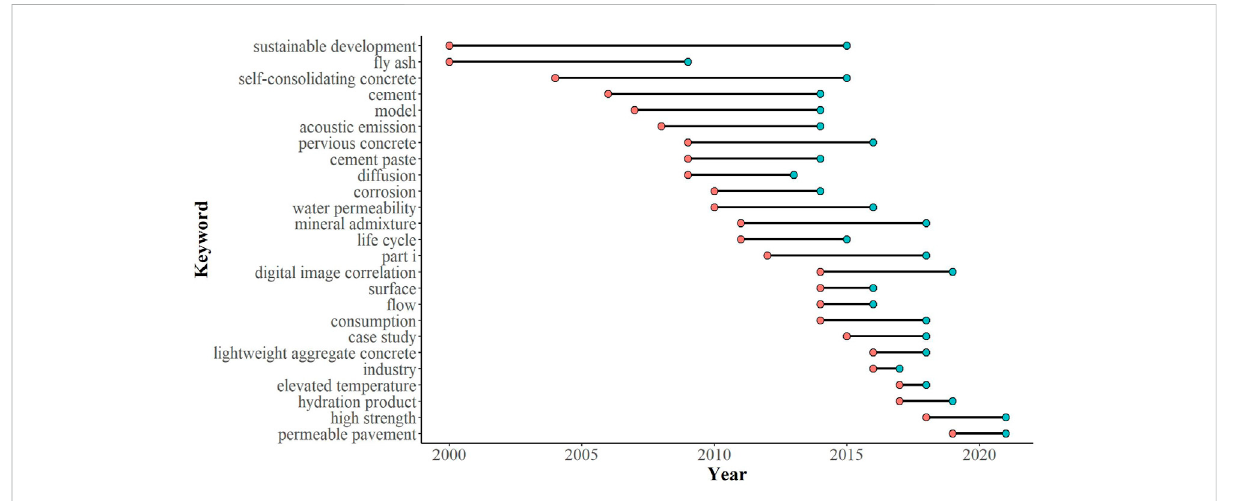
FIGURE 7 Summary of Ecological concrete mutation